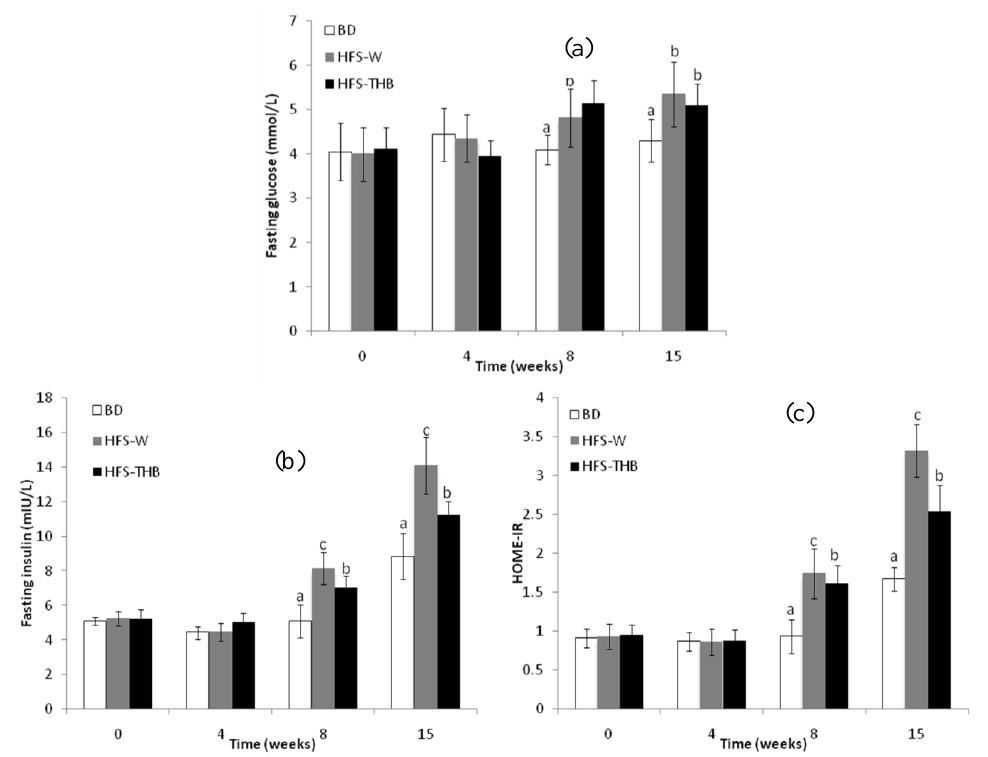
Figure 4. Concentration of plasma ( a ) glucose and ( b ) insulin, and ( c ) insulin resistance of rats during the 15-week study. BD, basal diet; HFS-W, high-fat-sucrose refined wheat diet; HFS-THB, high-fat-sucrose whole Tibetan hull-less barley diet. Samples were analyzed using a one-way ANOVA followed by a Turkey post doc test Evaluations were taken among three groups, a, b, c indicate statistical differences ( P < 0.05), the same letters indicate no statistical differences ( P >